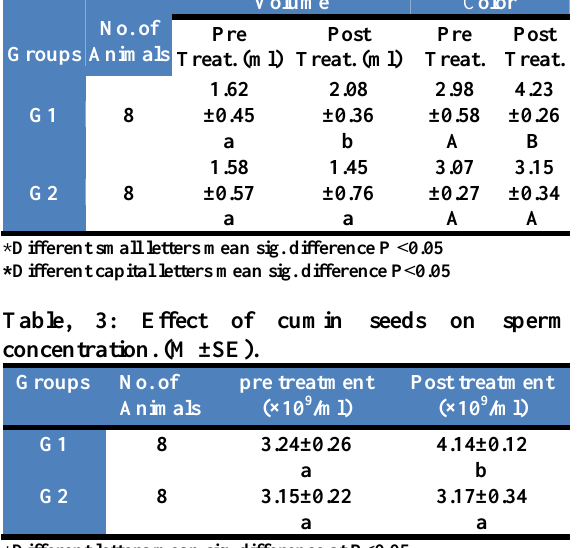
Table, 2: Effect of cumin seeds on volume (ml) and color of semen for local Iraqi bucks (M ±SE). No. of Groups Animals